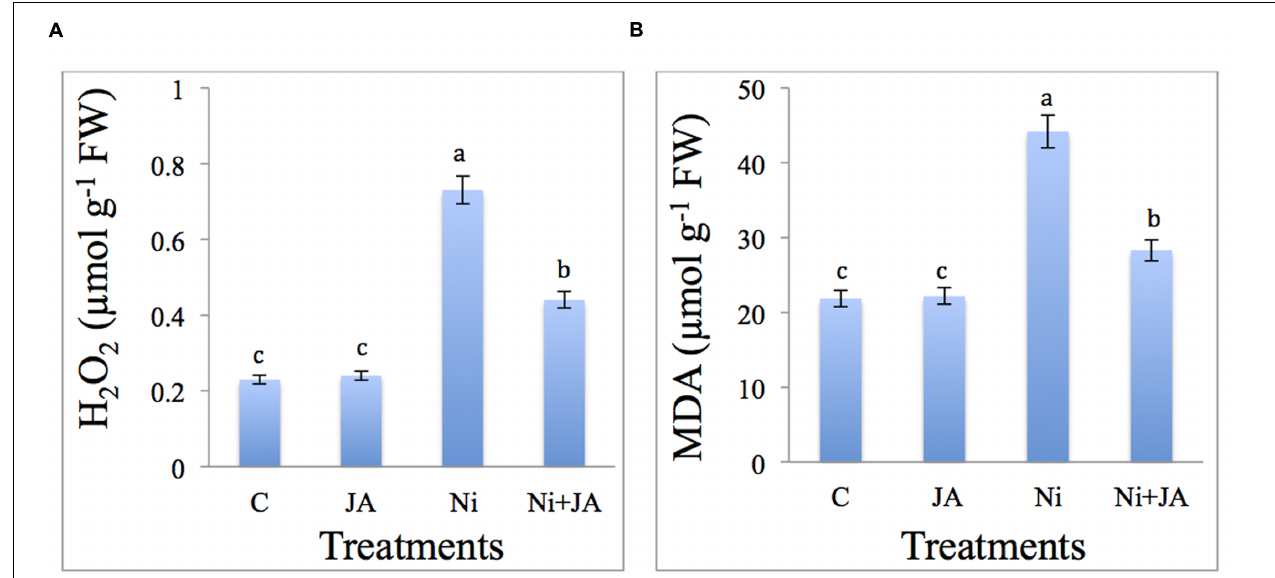
FIGURE 2 | Effect of Ni and JA individually and in combination on (A) H 2 O 2 and (B) MDA content in soybean seedlings. Different letters indicate significant difference between means at p ≤ 0.05 (DMRT). Values are means ± SE ( n =